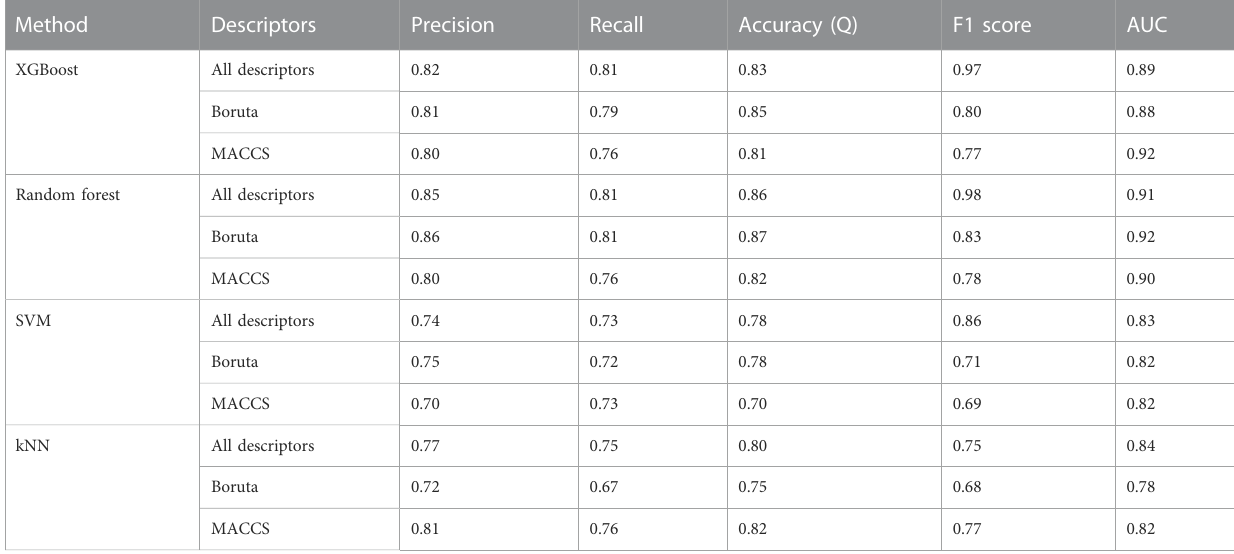
TABLE 1 Evaluation metrics for the test set. Method